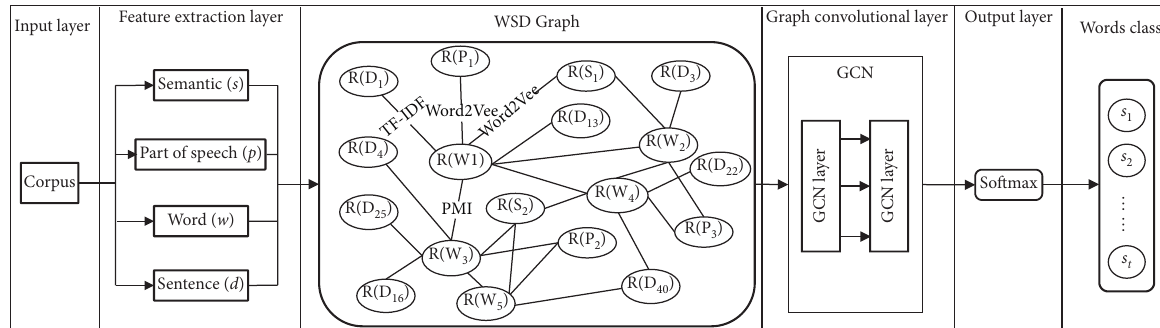
Figure 2: GCN word sense disambiguation.